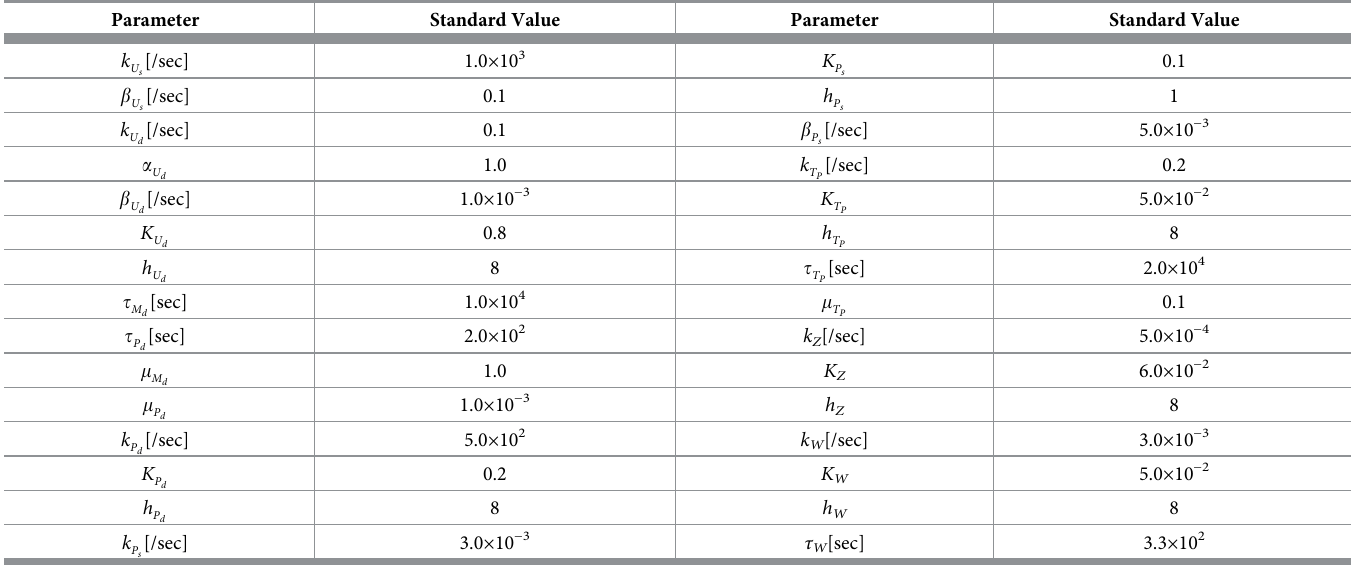
e-LTP induction requires NMDA receptor-mediated Ca 2+ influx into synapses and the activa- tion of Ca 2+ cascades. We defined the activity level of the stimulus-dependent Ca 2+ cascade as (Eq 1) and assumed that the synaptic skeleton expands and synaptic tag synthesis is acceler- U s ated when the U level exceeds the threshold. Conversely, the l-LTP–inducing stimulation pro- s tocol was distinguished from the e-LTP–inducing stimulation protocol because its protocol induced de novo protein synthesis. We defined the activity level of the PRP synthesis cascade in dendrites as U (Eq 2) and hypothesized that the synthesis of de novo PRPs would be accel- d erated when the U level exceeds the threshold. As the stimulation protocol, we adopted gluta- d mine uncaging and adjusted the model parameters so that e-LTP was induced by 30 pulses of Table 1. Model